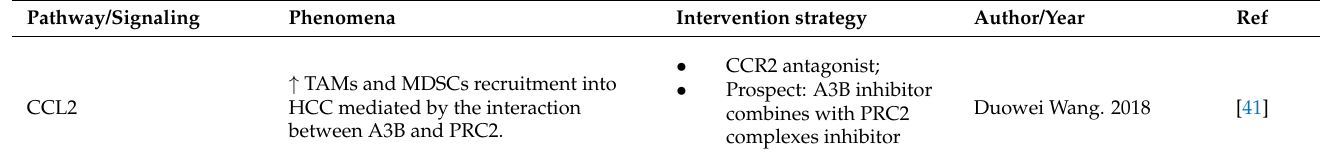
Table 1. Signals involved in the activation and recruitment of MDSCs in HCC.